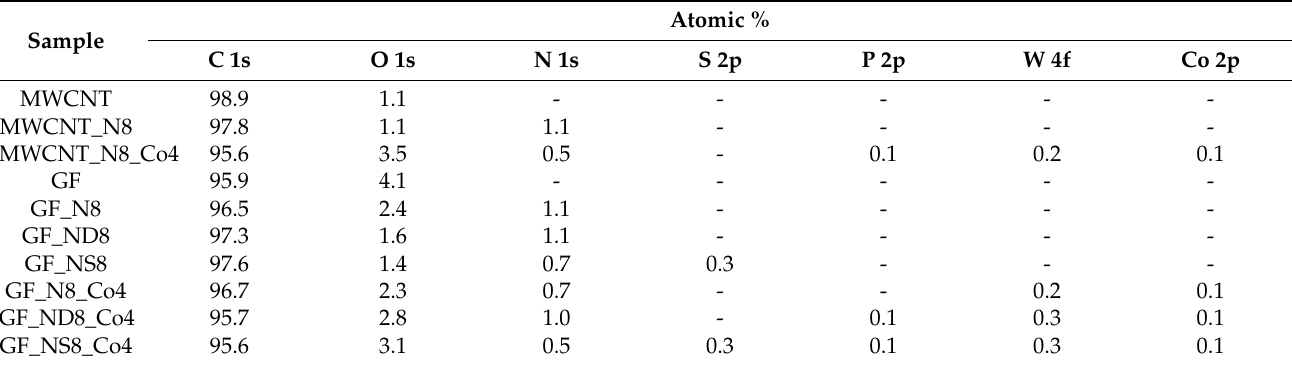
Table 1. XPS relative surface atomic percentages for all materials a .